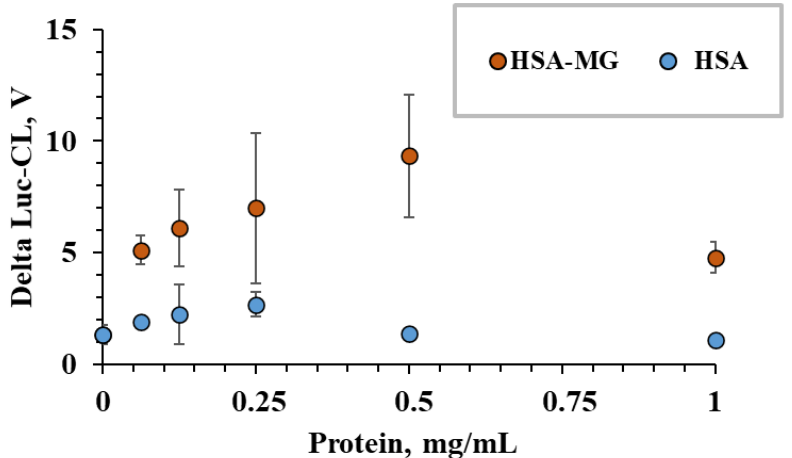
Figure 4. Dose-dependent stimulation of neutrophil Luc-CL by HSA and HSA-MG. Each point represents the amplitude of neutrophil CL response measured in triplicate as mean value and standard deviation.